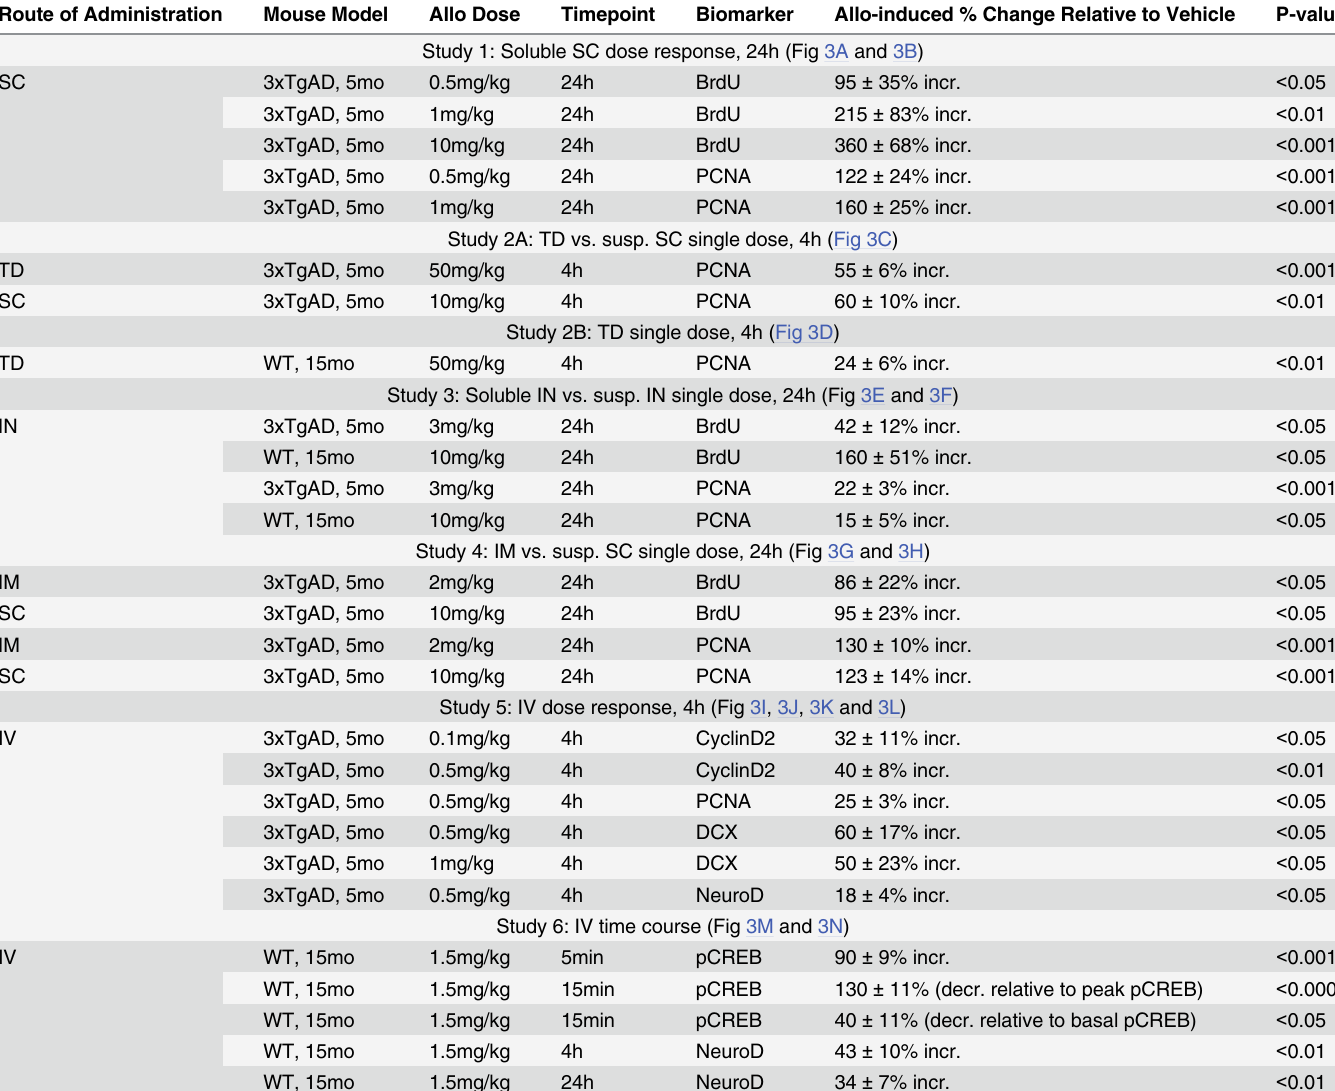
Table 2. Summary of mouse efficacy data and statistical